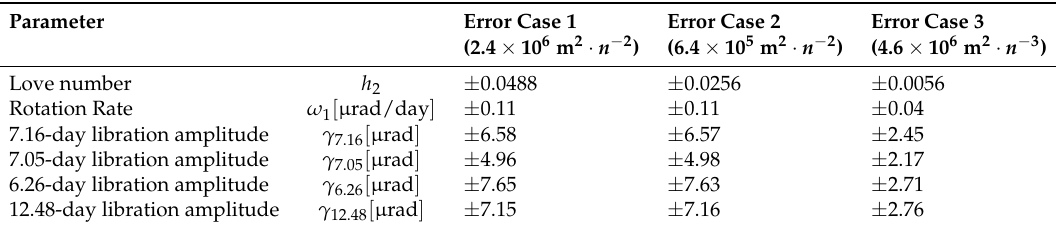
Figure 4. Resulting bias and standard deviation of Method 2’s results for 100 random realization for the libration amplitudes. Table 2. Derived measurement uncertainties for Ganymede’s rotation parameters and h 2 by using an equi-rectangular grid approach (Method